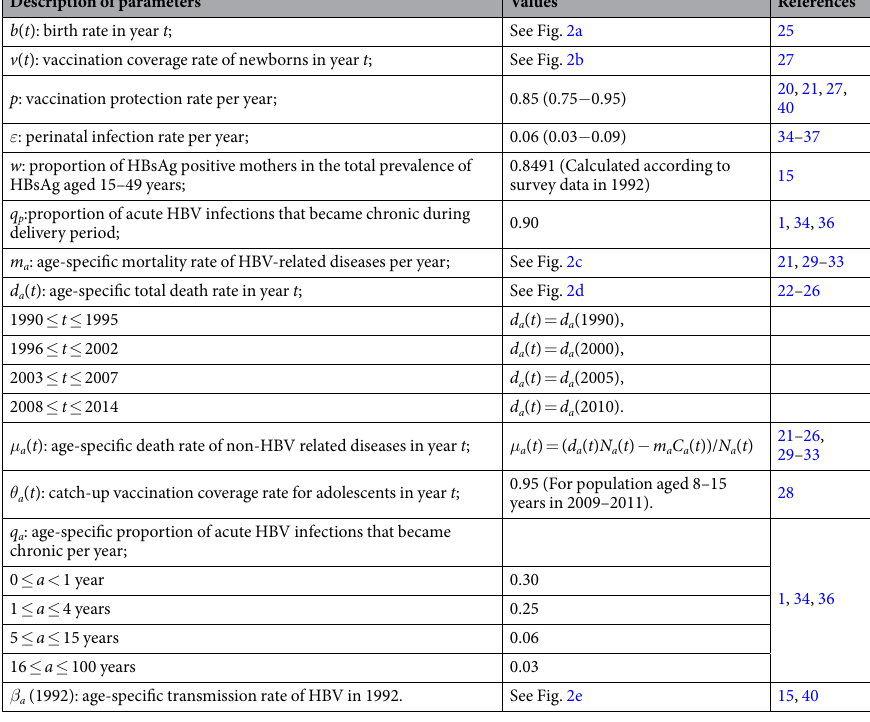
Table 2. Parameter values for input in transmission models (1) and (2) and references. Note. HBsAg, hepatitis B surface antigen; HBV, hepatitis B